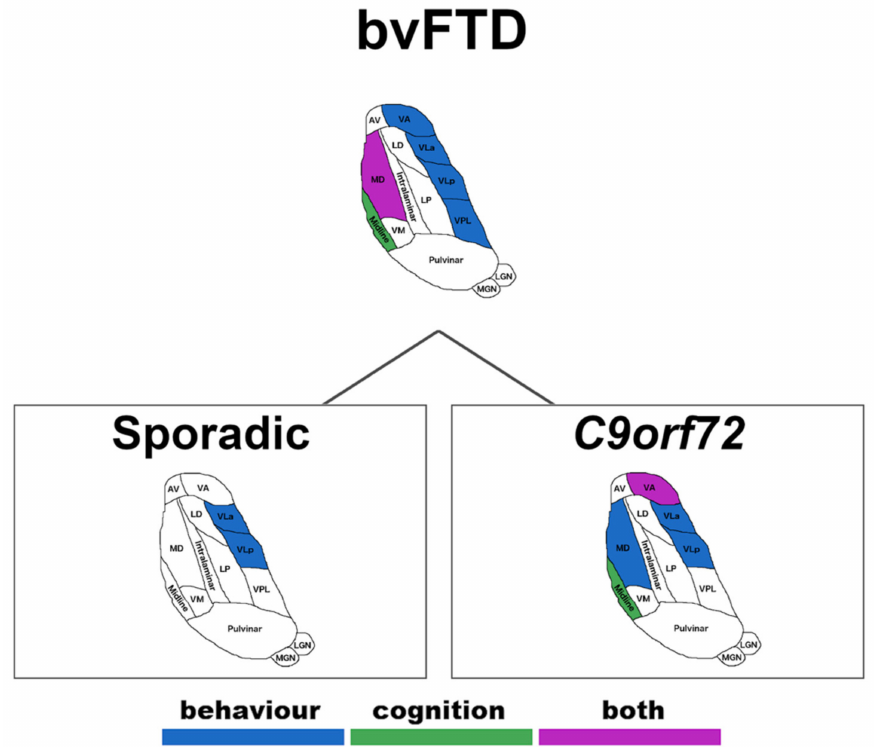
Figure 3. Pattern of neuroanatomical significant associations between thalamic regions and be- havioural and cognitive performance in bvFTD, further divided by sporadic form or presence of C9orf72 expansions. Abbreviations. Thalamus: AV—anteroventral, VA—ventral anterior, LD— laterodorsal, VLa—ventral lateral anterior, MD—mediodorsal, LP—lateral posterior, VLp—ventral lateral posterior, VPL—ventral posterolateral, VM—ventromedial, LGN—lateral geniculate nucleus, MGN—medial geniculate